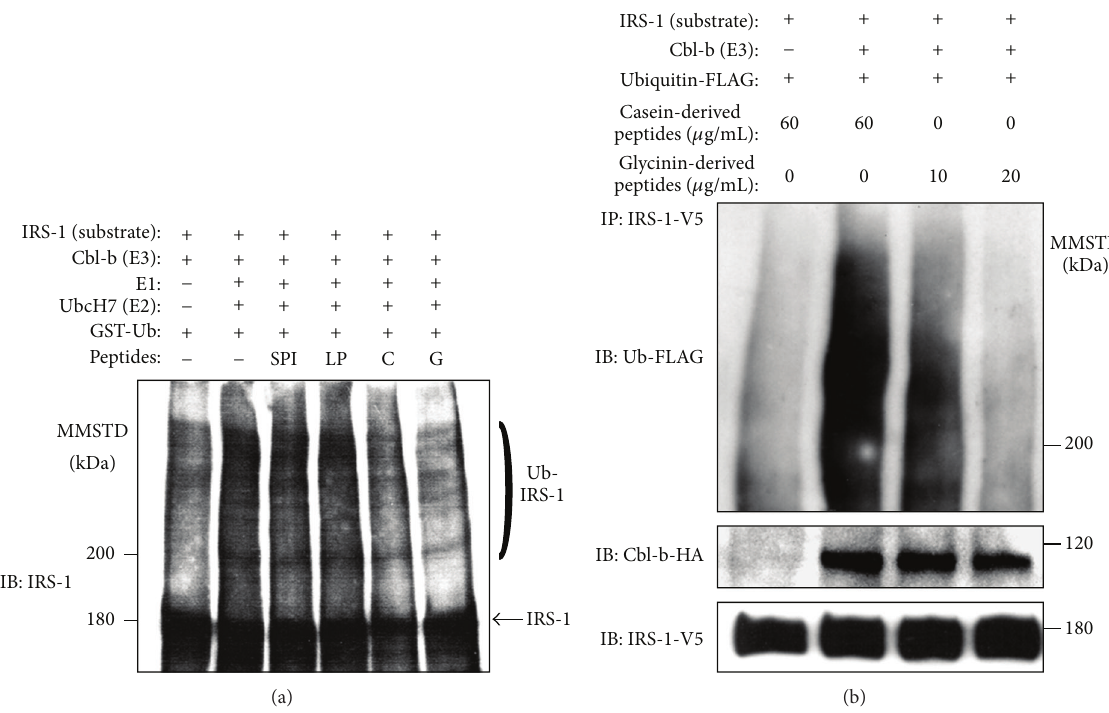
Figure 4: Inhibitory effect of soy-glycinin-derived peptides on Cbl-b-mediated IRS-1 ubiquitination. (a) Purified soy protein isolate (SPI), lipoprotein (LP), soy glycinin (G), and soy 𝛽 -conglycinin (C) were digested with trypsin, then 20 𝜇 g/mL of each of the hydrolysates was subjected to cell-free ubiquitination assay to elucidate their inhibitory effects on Cbl-b-mediated IRS-1 ubiquitination. (b) HEK293 cells transfected with mock vector/pCEFL-Cbl-b-HA, pcDNA3.1-rat IRS-1-V5, and pcDNA3-FLAG-Ubiquitin were treated with the indicated concentration of casein-derived (control) or soy-glycinin-derived peptides for 2 hours in the presence of 100nM epoxomicin and 10ng/mL IGF-1.Celllysatesfromthesecellswereimmunoprecipitatedwithananti-V5antibody.Theimmunoprecipitatesweresubjectedtoimmunoblot (IB) analysis for the indicated proteins. MMSTD: molecular mass standards. Representative findings of three experiments with matching results. Table 3: Daily intake of food, protein, and energy in mice.